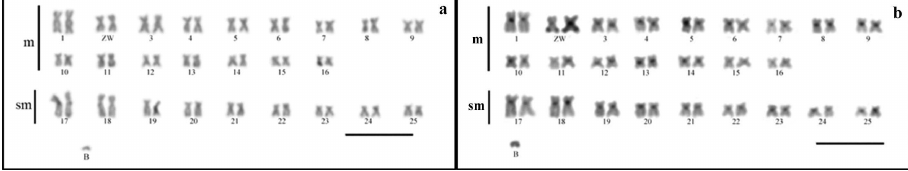
Figure 2. Characidium alipioi karyotypes arranged from mitotic metaphases after to conventional Giemsa- staining ( a ) and C-banding ( b ). Bar = 10